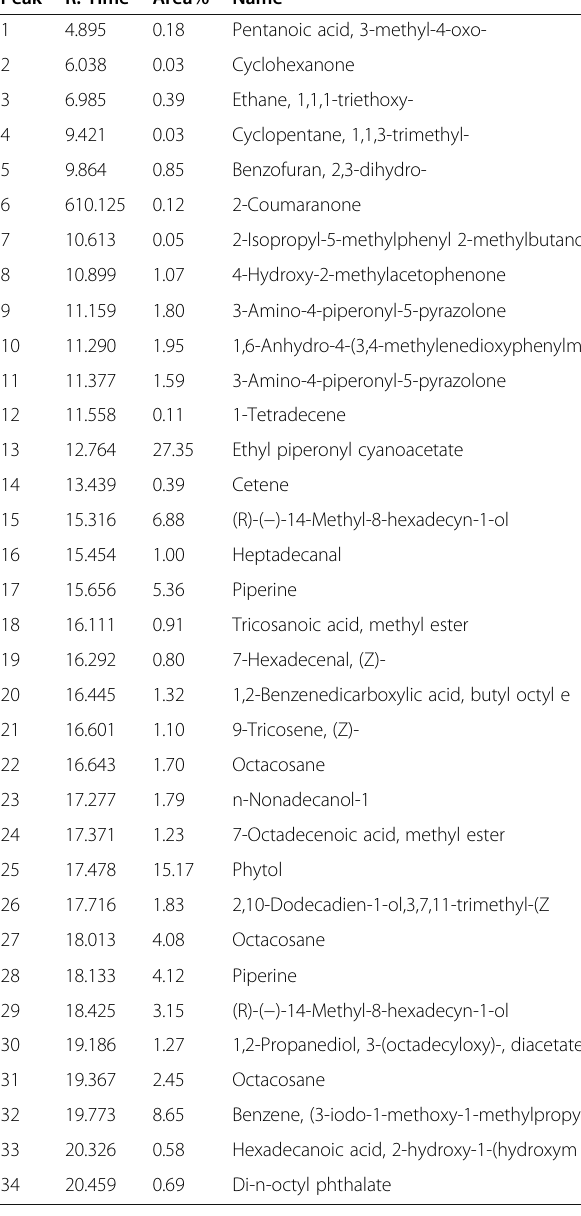
Table 8 Chemical composition of the ethyl acetate fraction of P. guineense following GC-MS analysis Peak R. Time Area%